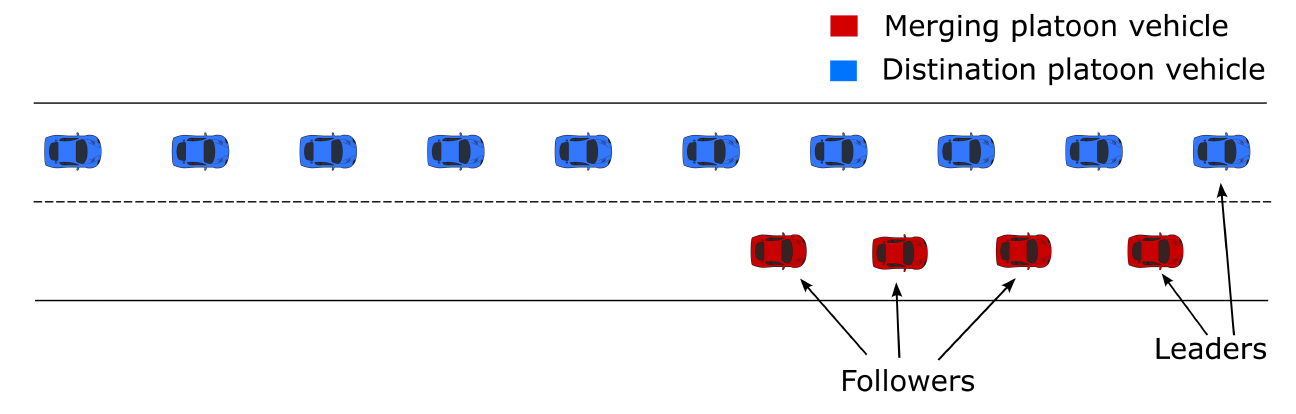
Figure 1. Initial platoon